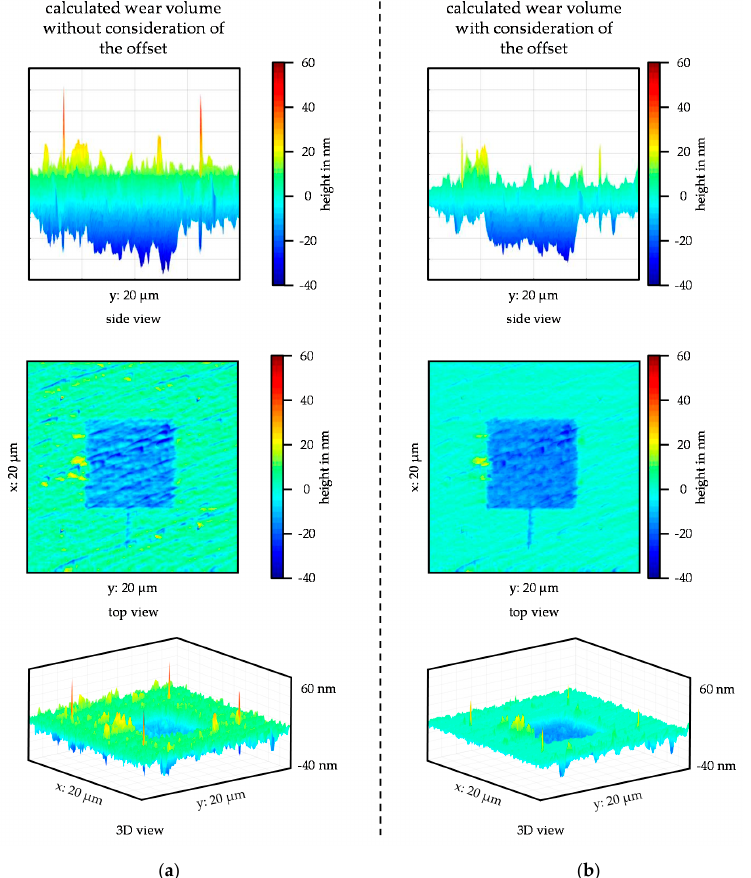
Figure 6. Results of the subtraction of the post ‐ and pre ‐ scan: ( a ) Without consideration of the offset; ( b ) With consideration of the offset.